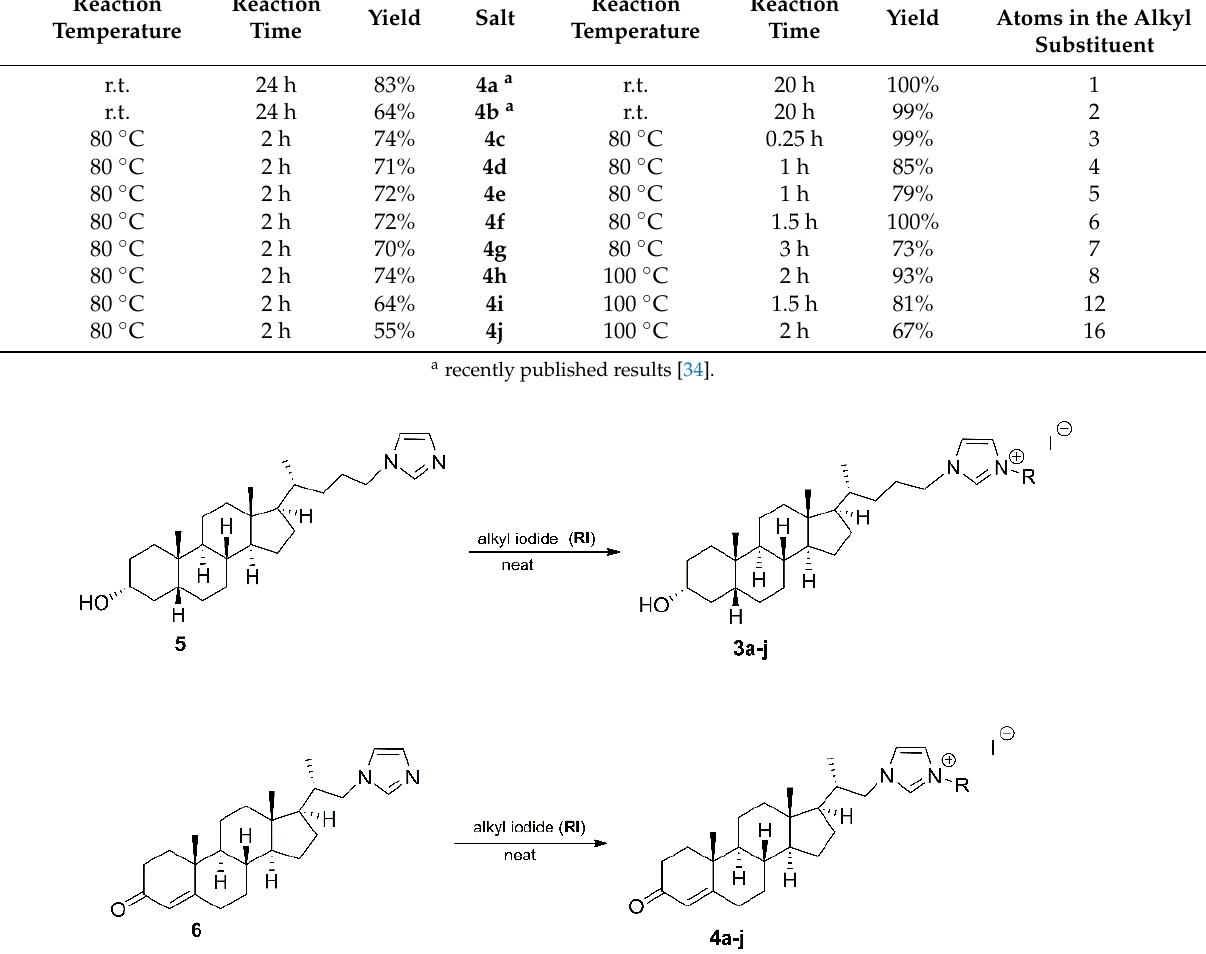
Table 1. Synthesis of steroid-based